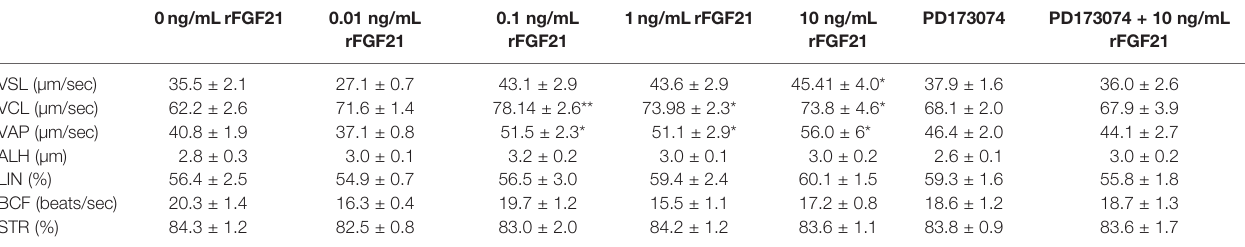
TABLE 2 | Kinematic parameters of human spermatozoa exposed to